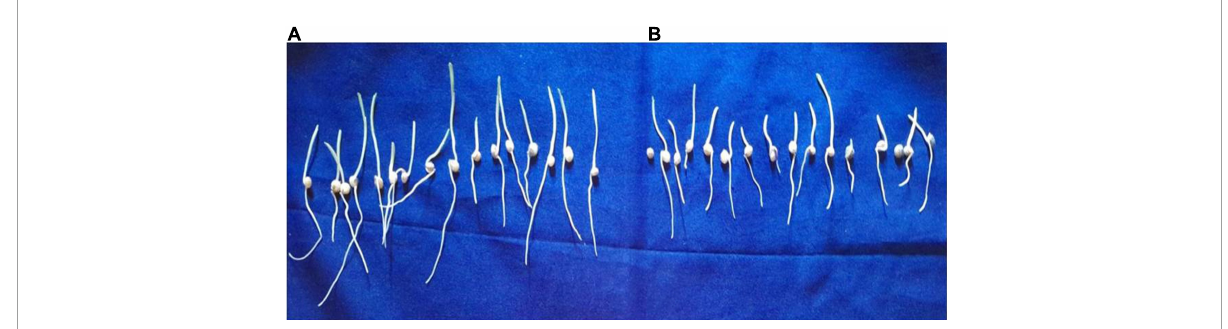
FIGURE6 Efficacy of S. rochei on plant growth promotion by the roll-towel method. (A) Treated with culture filtrate of S. rochei ; (B) Treated with sterile water (control) on the 7th day of germination.